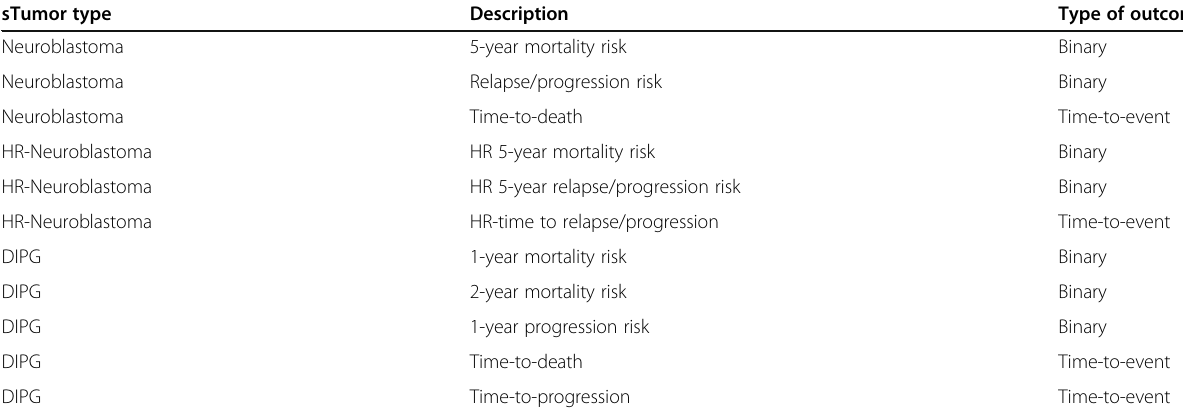
Table 1 Clinical endpoints and model type sTumor type